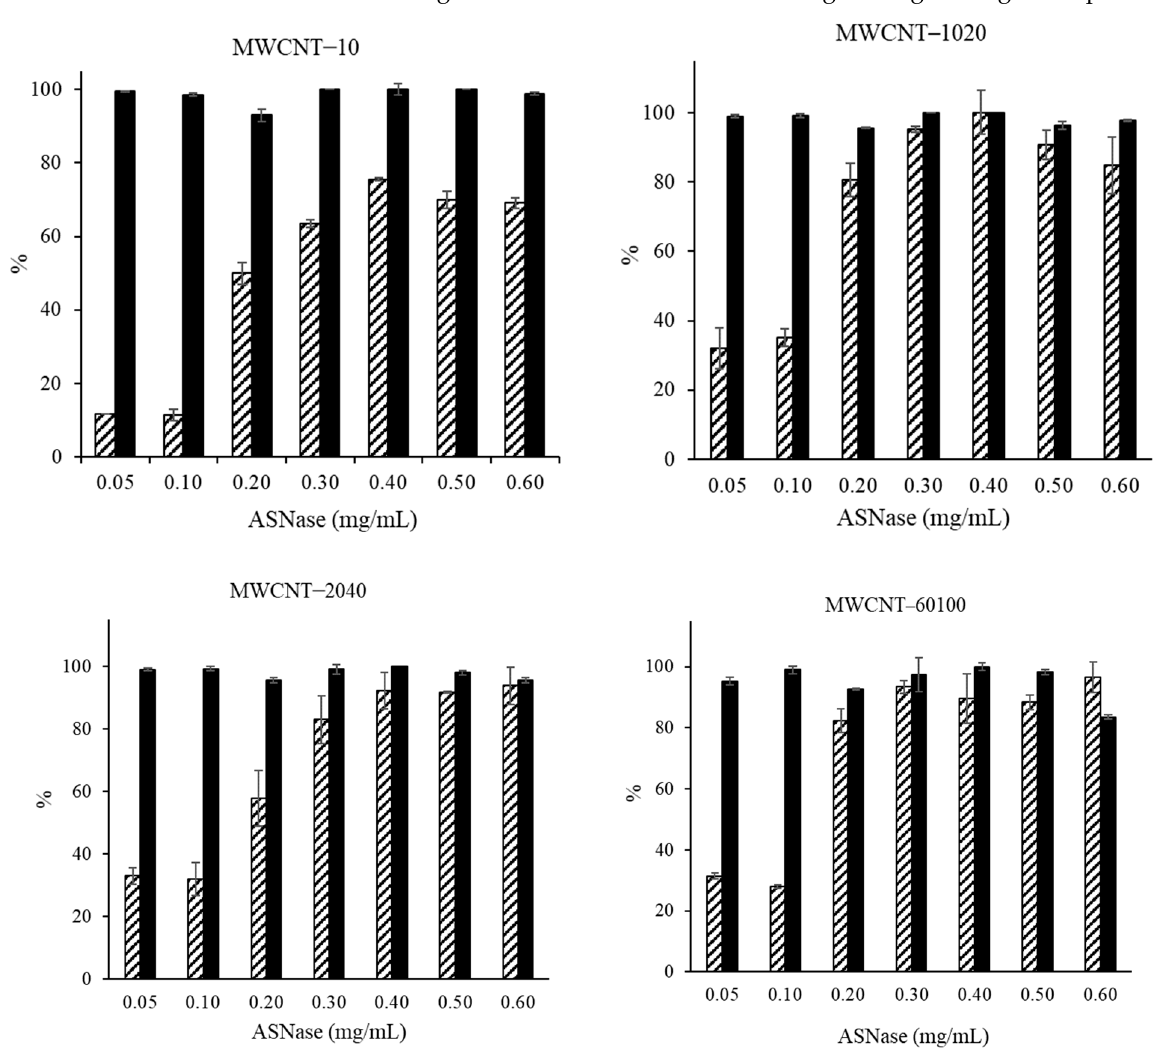
Figure 4. Effect of L-asparaginase (ASNase) concentration on the immobilization yield ( IY ) ( ■ ) and relative recovered activity ( RRA ) ( ). ASNase immobilization onto 2 mg of pristine multi-walled carbon nanotubes (MWCNTs) at pH 8.0 for 60 min. Error bars correspond to the standard deviation between replicates.